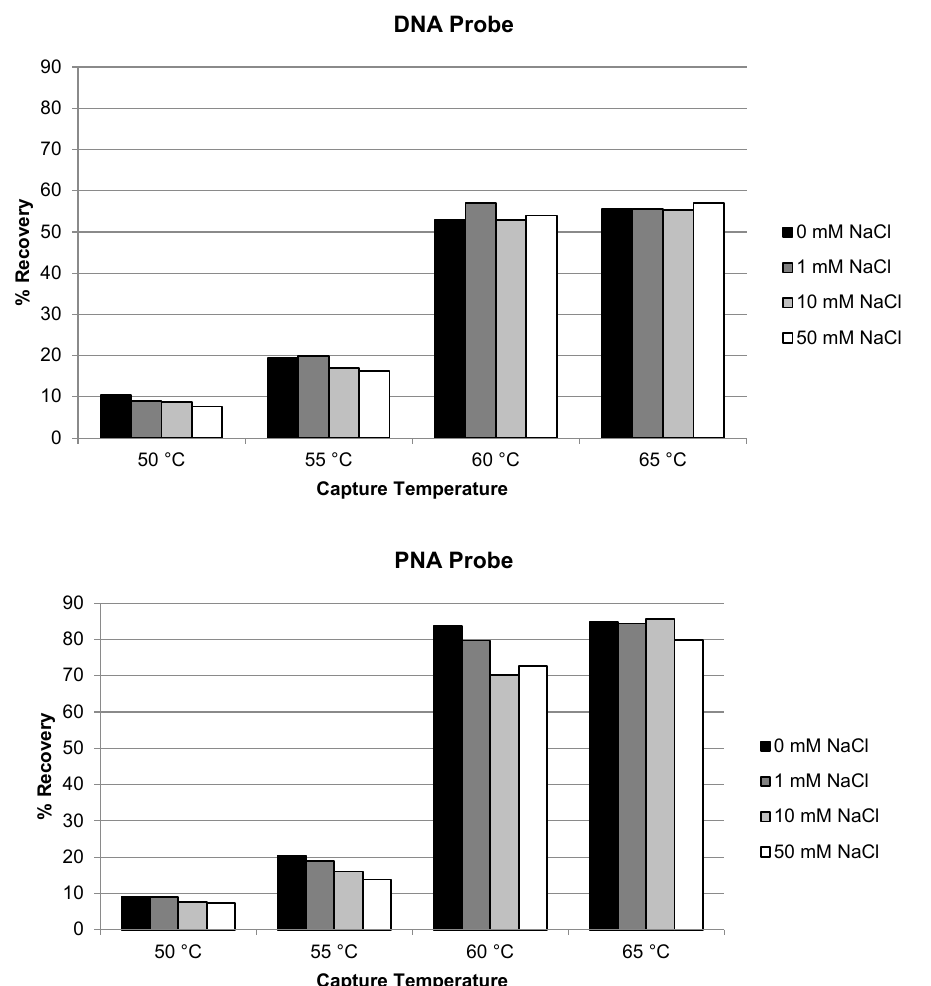
Figure 3. Optimization of temperature and salt concentration for the recovery of siRNA-01 using DNA probe and PNA probe.